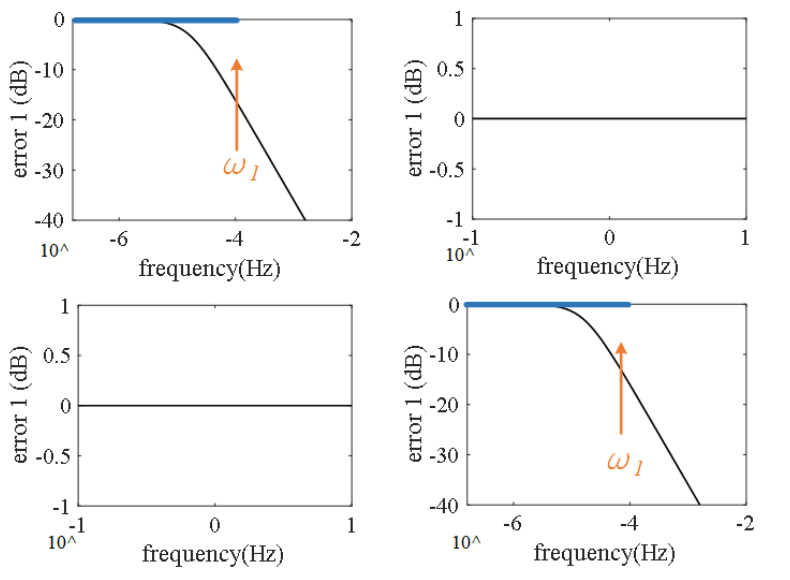
Figure 4. Sensitivity of We −